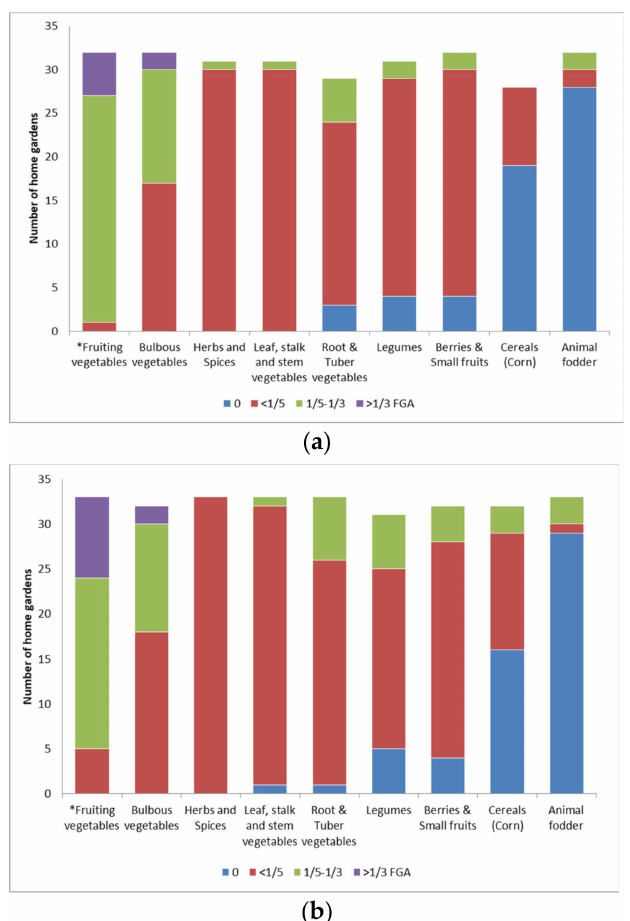
Figure 1. Preference given to crop groups as parts of the food growing area (FGA) across studied home gardens in: ( a ) lowland settlements (LL), n = 31; ( b ) semi-mountainous and mountainous settlements (SMM), n = 33. * Fisher’s exact tests p -values ≤